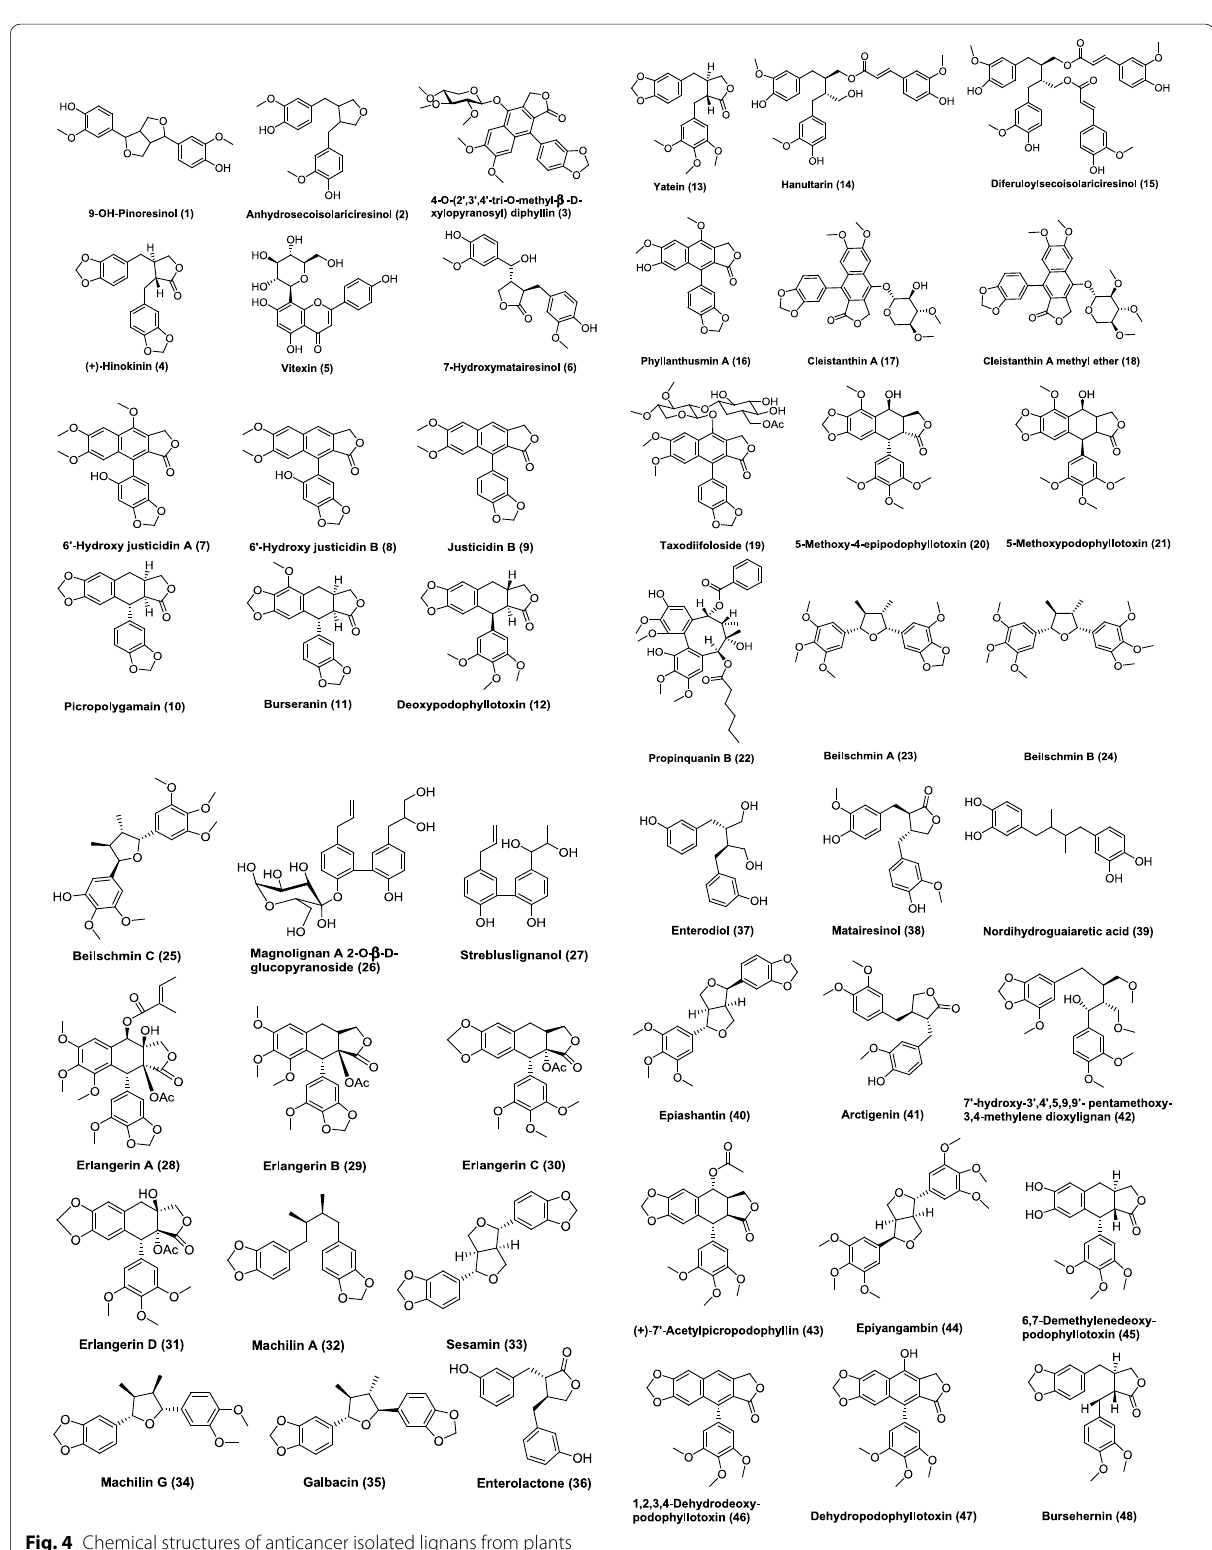
Fig. 4 Chemical structures of anticancer isolated lignans from